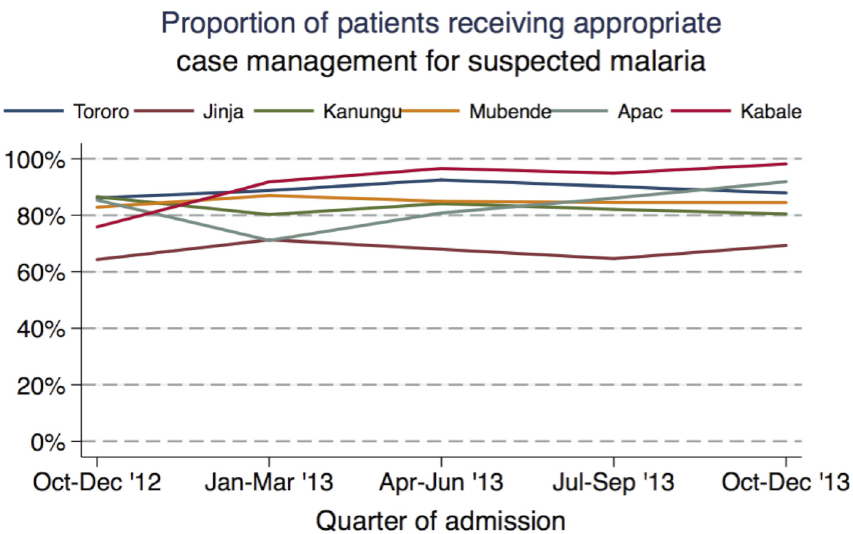
Fig 2. Trends in appropriate inpatient case management of suspected malaria, by health